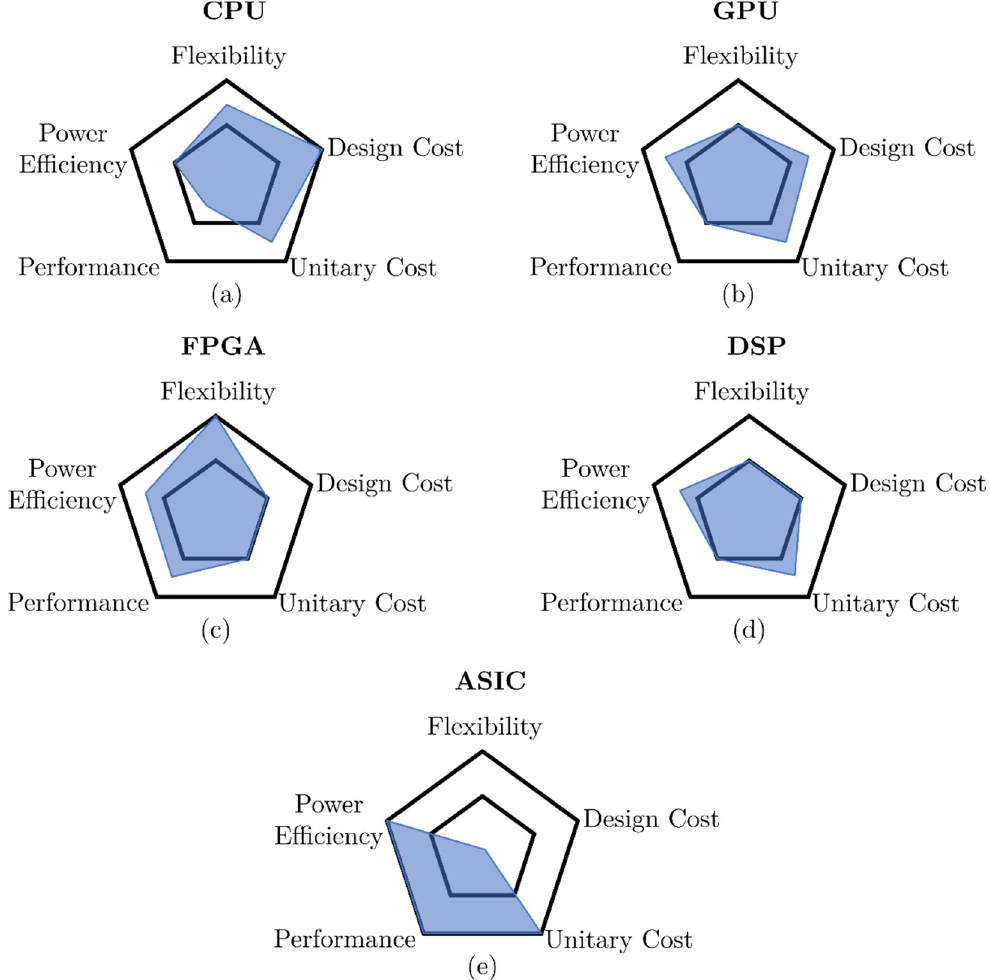
Figure 6. Summary of the comparison between the five hardware architectures discussed in this paper, based on different parameters to be considered when implementing image processing for medical imaging applications. In detail, ( a ) Central Processing Units (CPUs) are probably the most widespread technology, as every PC is equipped with one of them. Their availability, flexibility and ease-of-use make them the perfect prototyping candidates when deploying algorithms or developing code. ( b ) Graphics Processing Units (GPUs) offer more raw power than a CPU while being less flexible. ( c ) Digital Signal Processors (DSPs) are cheap and easy to use but do not perform well outside their niche. ( d ) Field Programmable Gate Arrays (FPGAs) offer a unique combination of flexibility and high performance, as they can be programmed to perform similarly to a given highly specialized platform. ( e ) Application Specific Integrated Circuits (ASICs) are extremely geared towards high-performance and low unitary cost for a high production so that the low variable costs may offset the high fixed